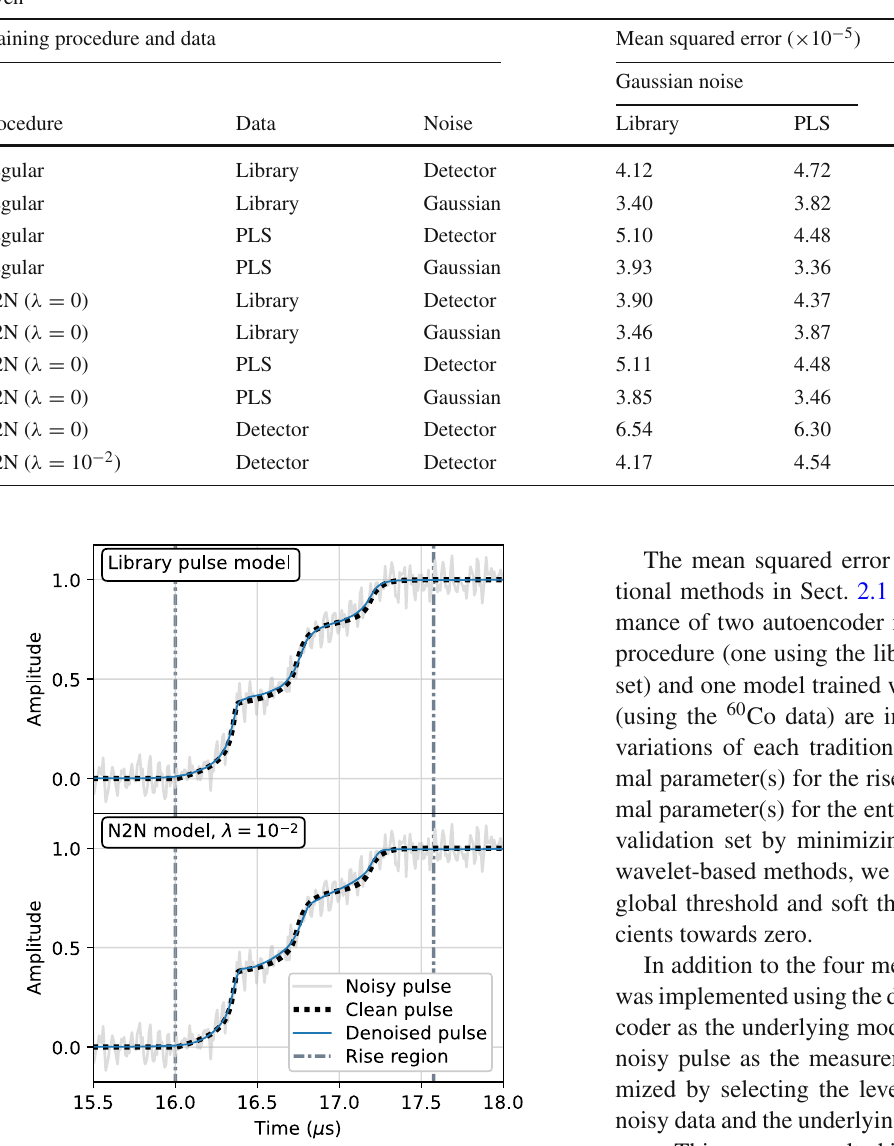
Fig. 4 An example multi-site event from the library dataset. Included in each plot is the simulated pulse with artificial noise (solid light line), thecleanunderlyingpulse(dottedline),andthecorrespondingdenoised pulse (solid dark line) from the regular library pulse model (top) and Noise2Noise model